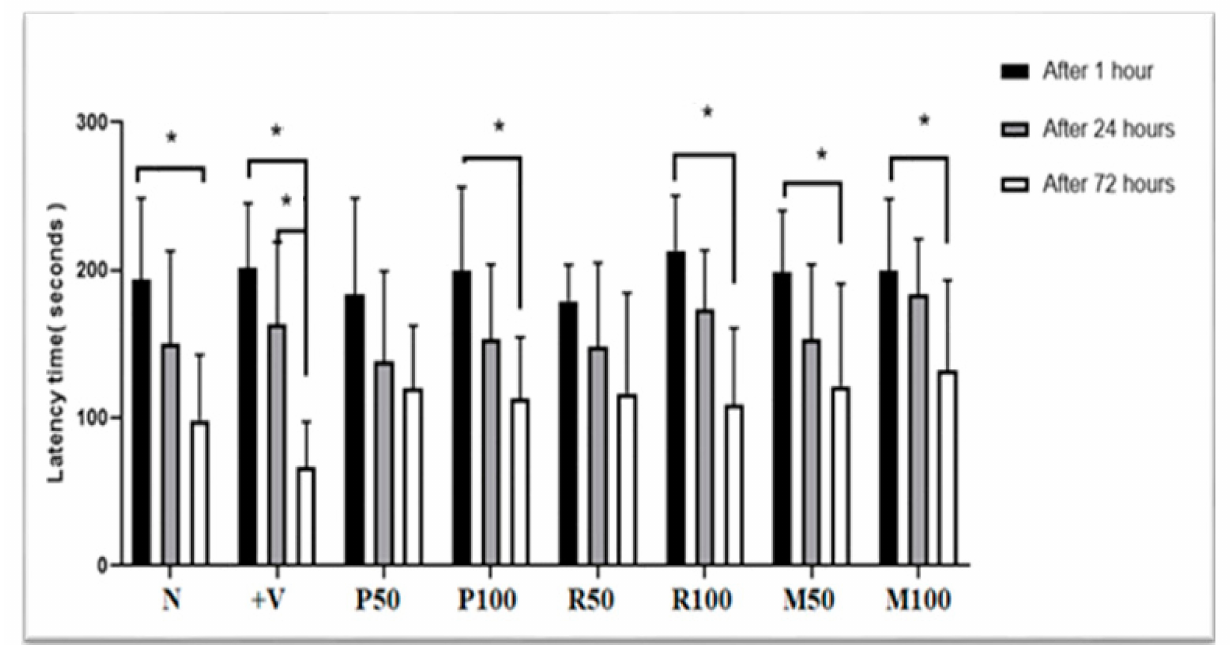
Figure 3. Nootropic PA test results. Each rat was subjected individually to the PA test (after 1 h, 24 h and 72 h from the last electrical foot shock), and the time needed to enter the dark room was recorded as PA transition latency time (in seconds). Data are presented as mean ± standard deviation (SD), n = 6 and the statistical analysis was performed by one-way ANOVA followed by Tukey’s post-hoc test; * p < 0.05 considered statistically significant values. Comparisons were within the groups (between 1, 24, and 72 h for each group). N, Normal; +V, positive; P, peppermint oil extract; R, rosemary oil extract; PR, both peppermint oil and rosemary oil extracts in which M50 means: 25 + 25 mg of both oil extracts, while M100 means 50 + 50 mg of both